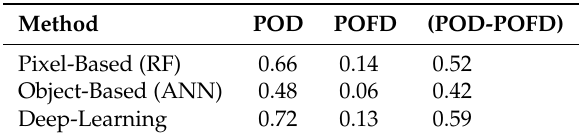
Table 5. The probability of detection (POD) and probability of false detection (POFD) scores for the different machine learning